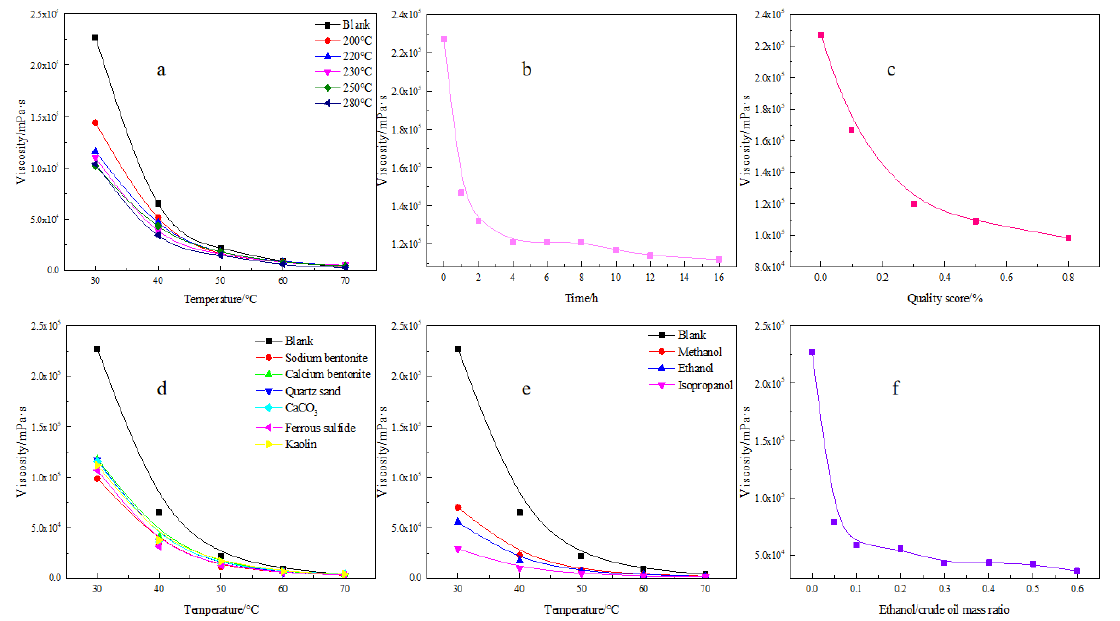
Figure 6. Viscosity reduction under different reaction conditions depending on. ( a ) temperature; ( b ) time; ( c ) dosage; ( d ) minerals composition; ( e ) solvents and ( f ) ethanol.